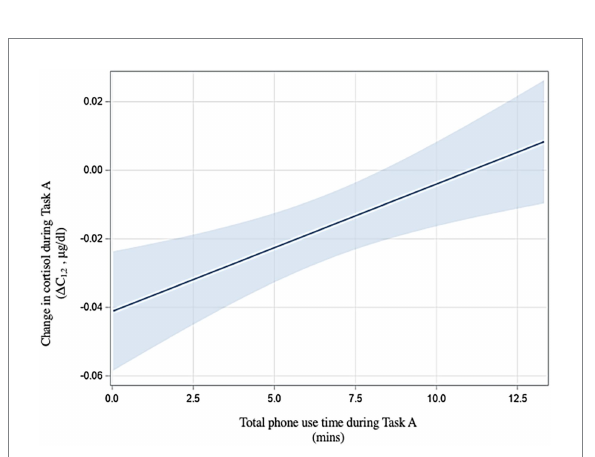
FIGURE 5 Relationship between phone use time and physiological stress (H2b) with 95% confidence interval.